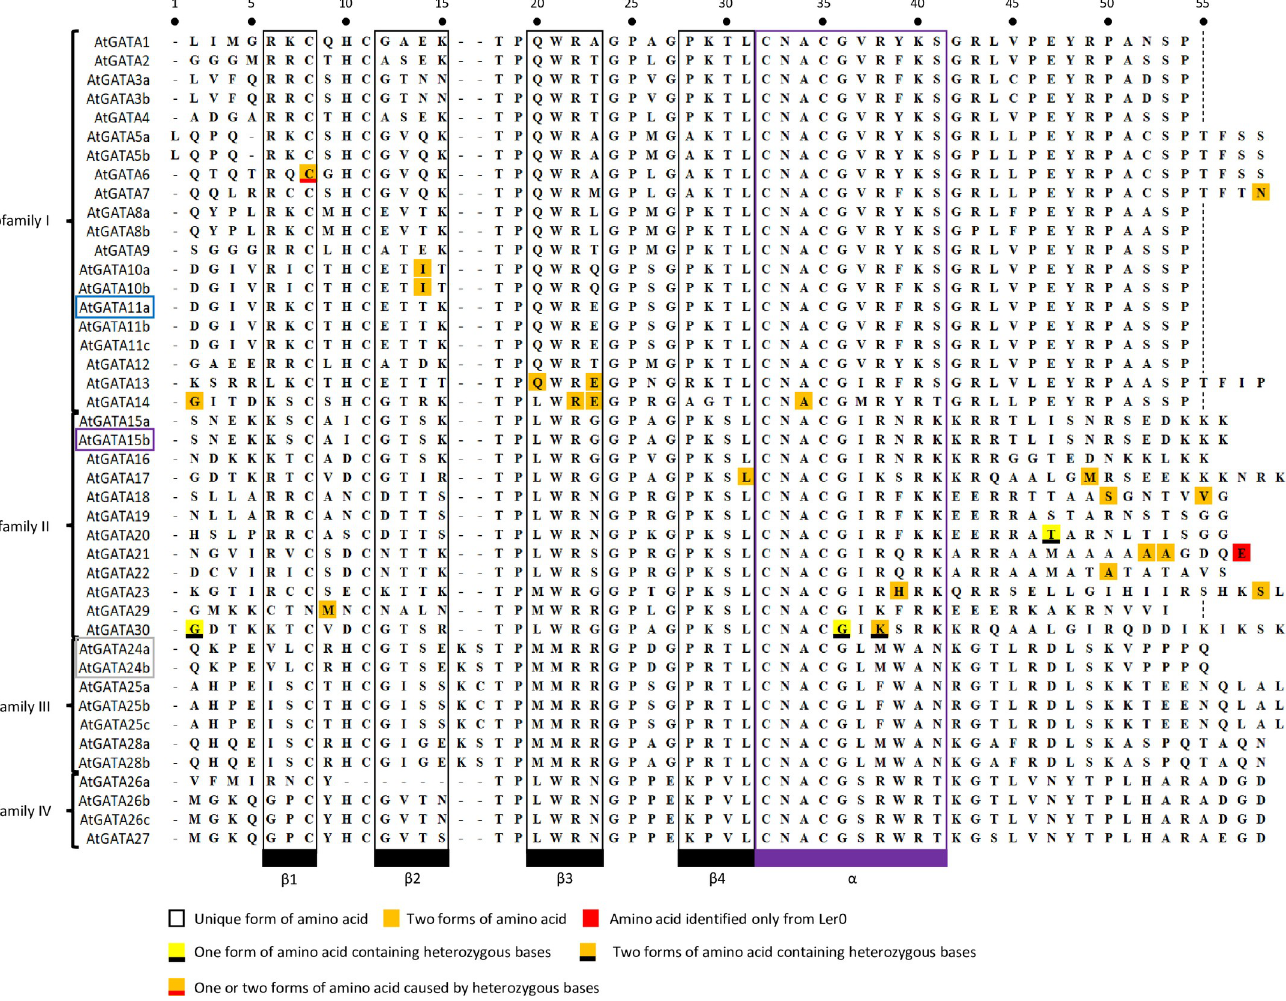
Fig 5. Amino acid patterns of GATA domain from 19 A . thaliana genomes. It shows amino acid patterns of GATA domains of GATA TFs from 19 A . thaliana genomes. Purple colored GATA gene name indicates GATA TFs found only in Kn0 genome and grey colored GATA gene names mean that some A . thaliana genomes do not have GATA gene. Blue colored GATA gene name presents uniquely found in A . thaliana Col0 genome. Colors on aligned amino acids of the GATA domain indicate the number of amino acids in that position. Black and purple boxes under the alignment indicate the position of beta-sheet and alpha helixes, respectively. Black and purple border boxes indicate an area of the beta sheet and alpha helix